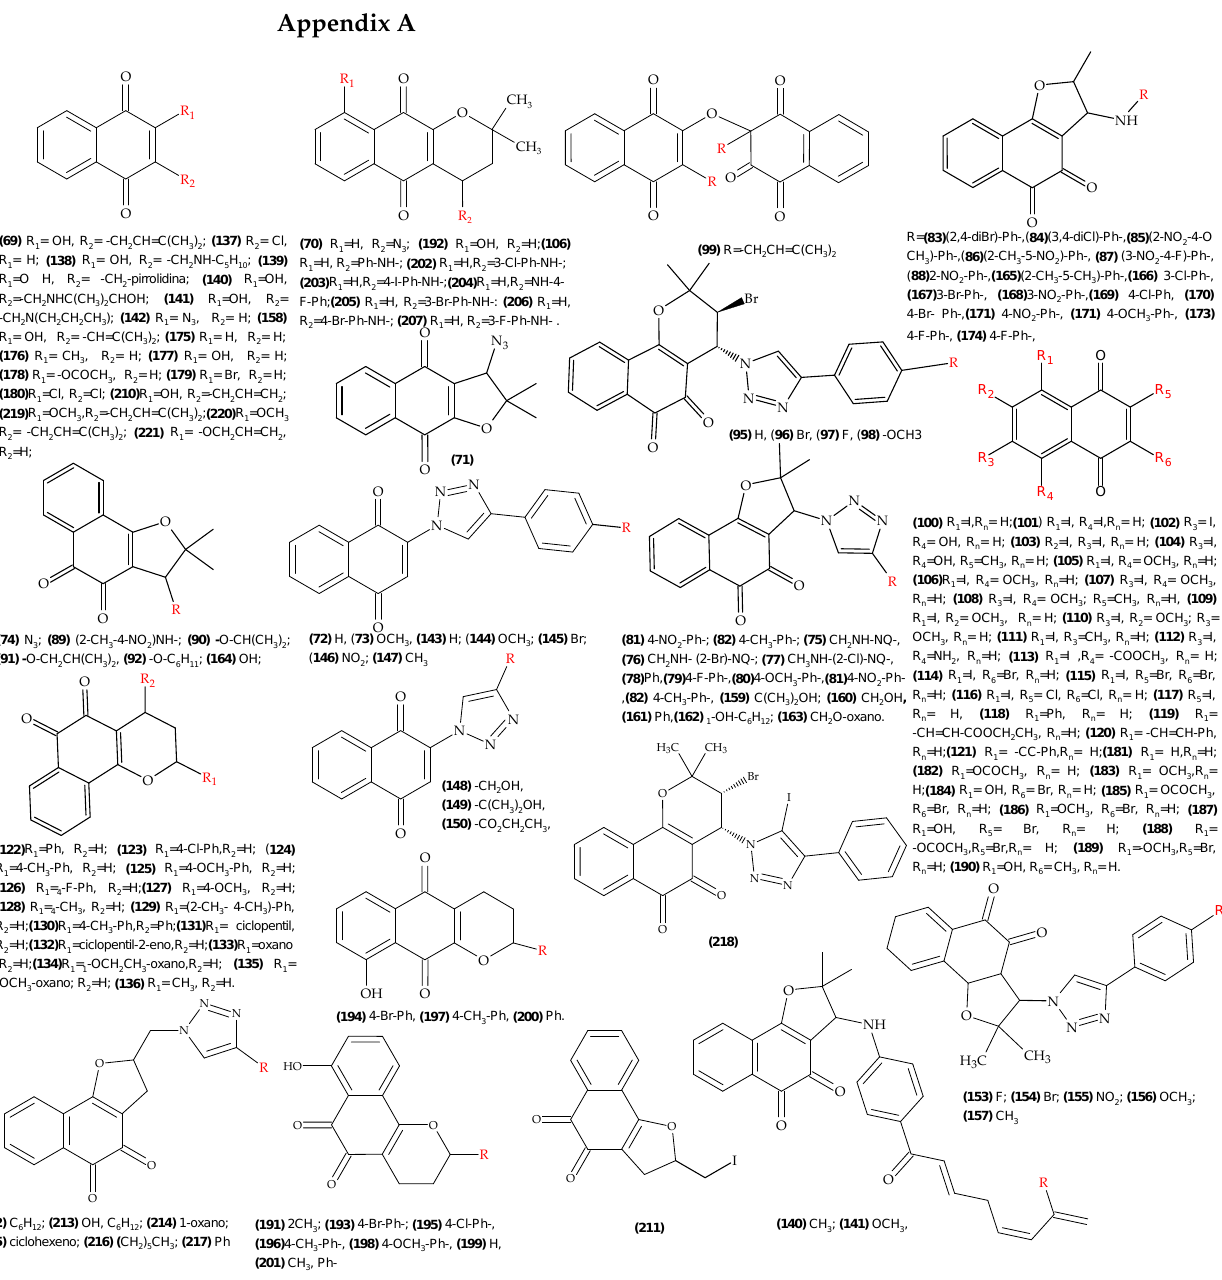
Figure A1. Molecules with reported biological activity (IC 50 ) used for the development of the QSAR anti- T. cruzi .